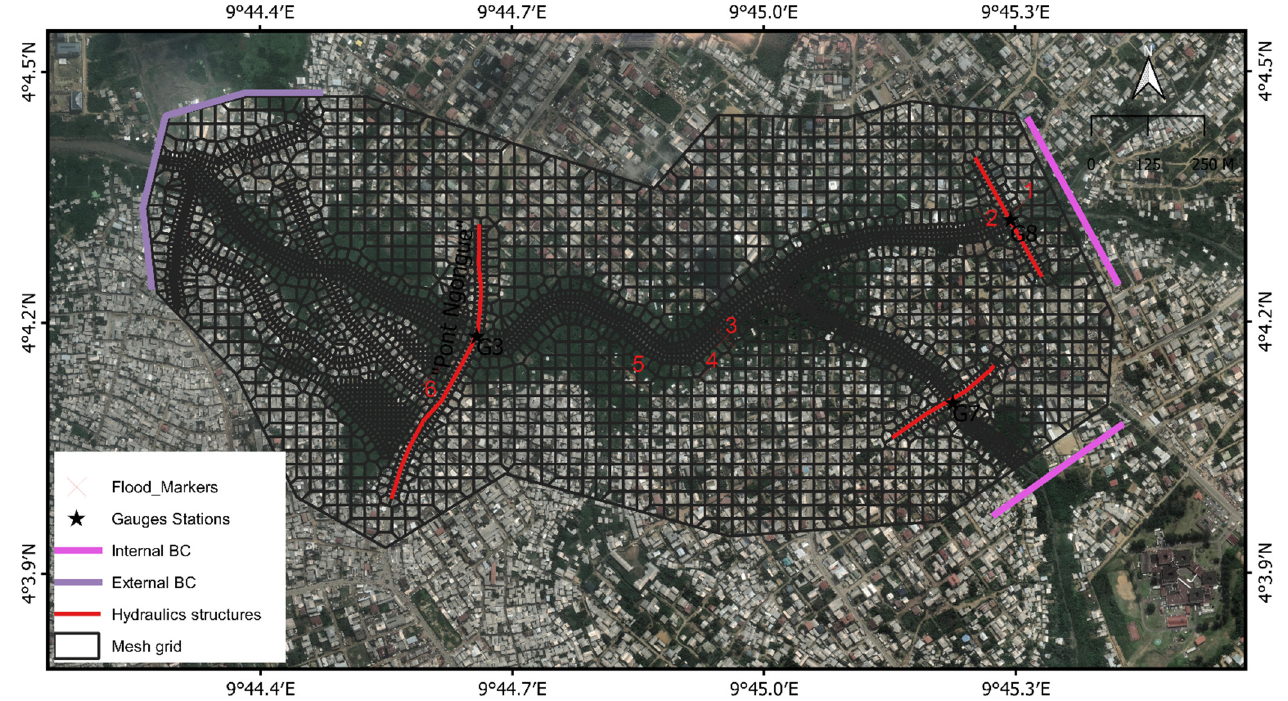
Figure 4. Simulation domain, computational mesh grid, and boundary conditions defined for assessing flood in Makèpè Missokè.